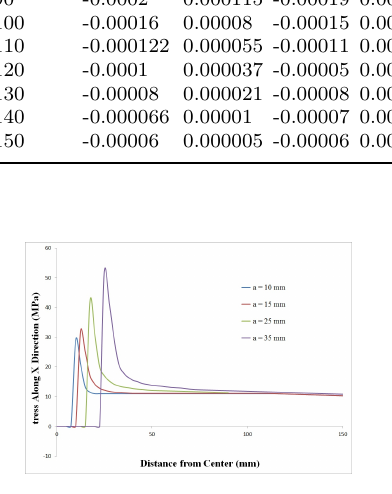
Figure 9. Evolution of σ y at different crack